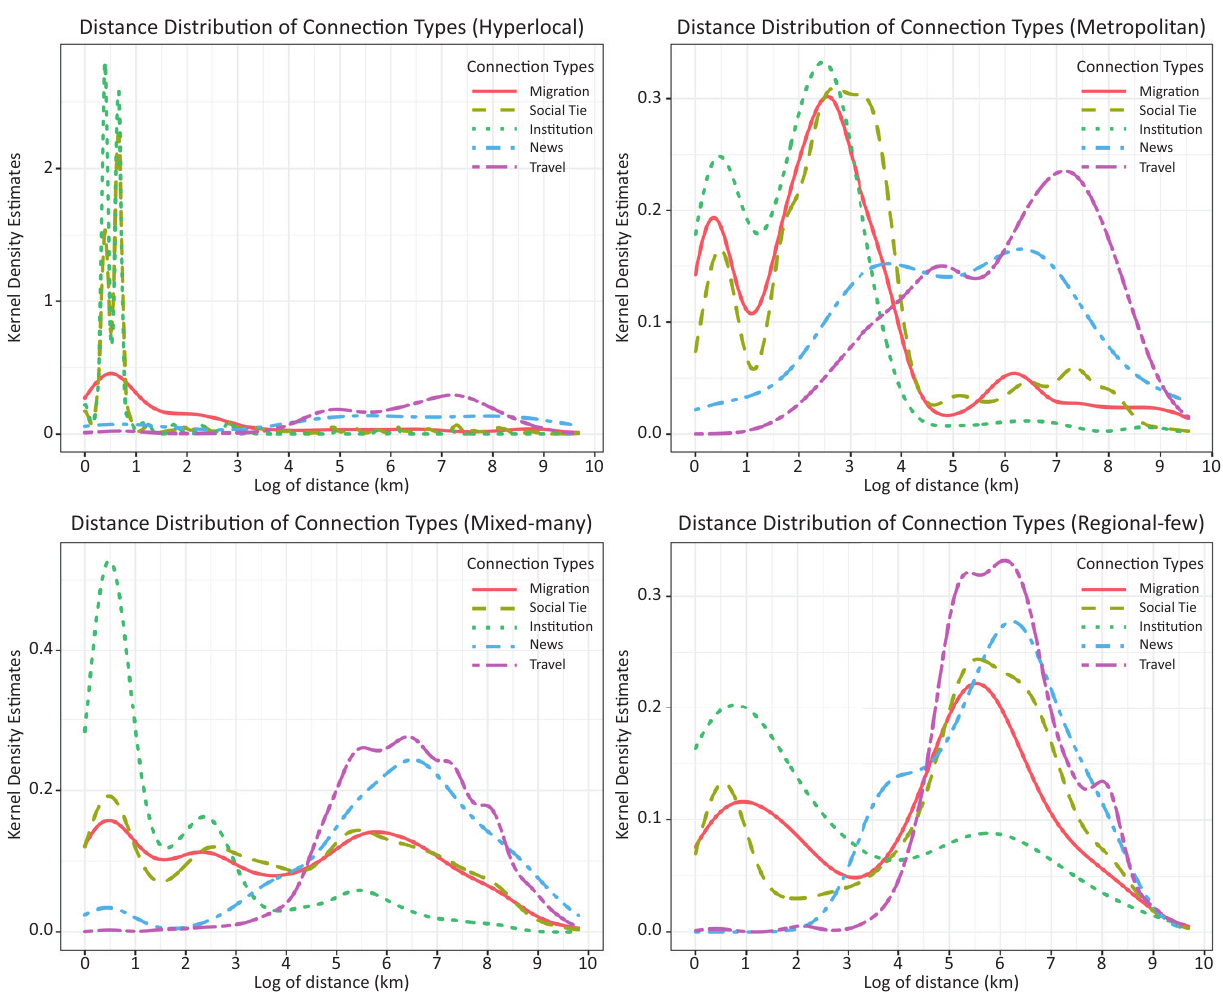
Figure 3. Distance distribution of various connection types for each of the four clusters. Notes: The Y‐axis shows the ker‐ nel density estimates of the count of a type of connection at various distances; higher y values indicate a greater likeli‐ hood/frequency of